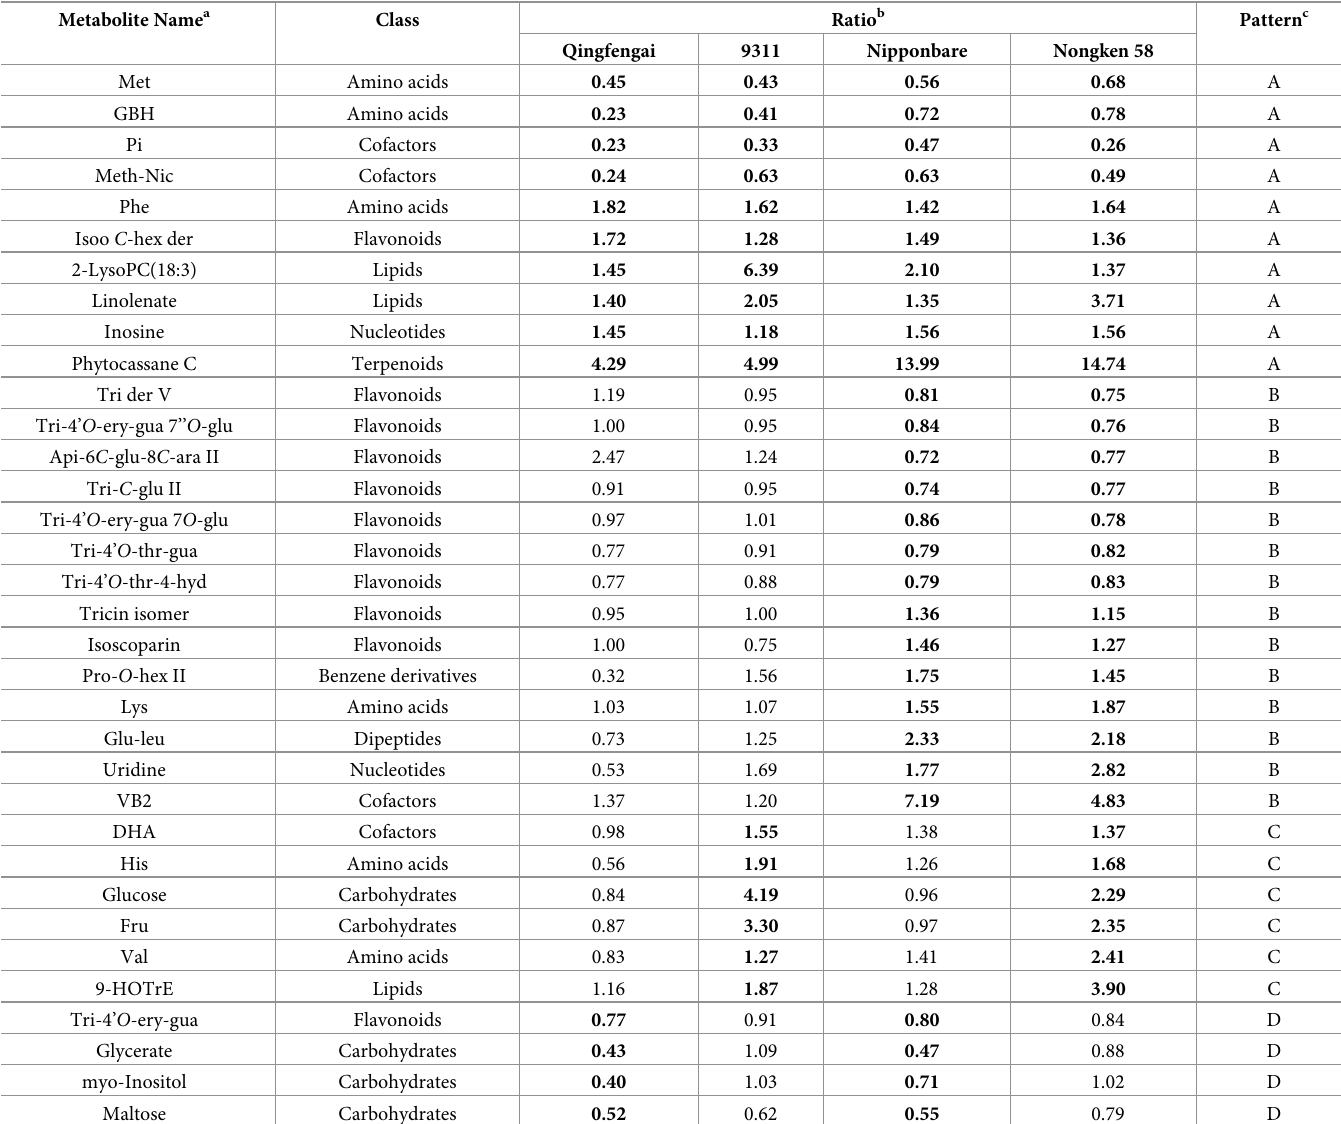
Table 1. Partial list of significantly changed metabolites during flag leaf maturation.